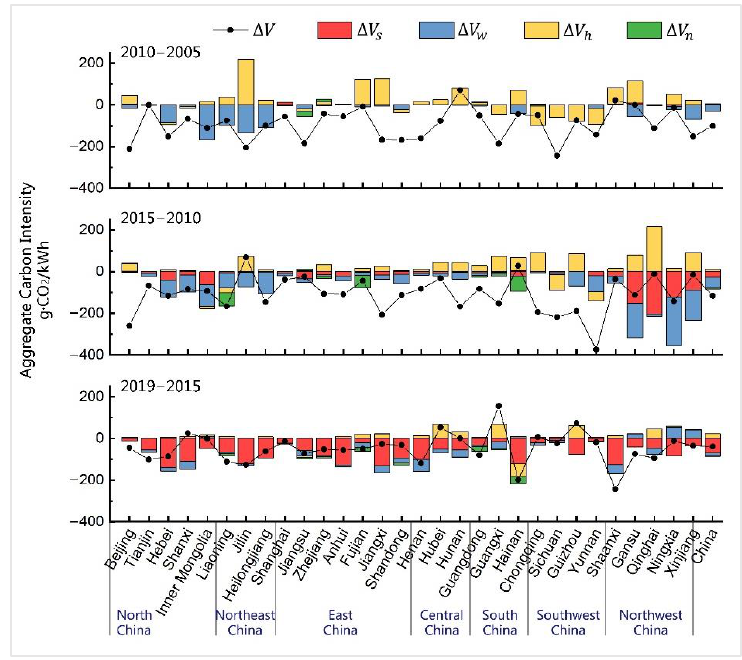
Figure 3. Performance of respective effects of different kinds of non-fossil power.